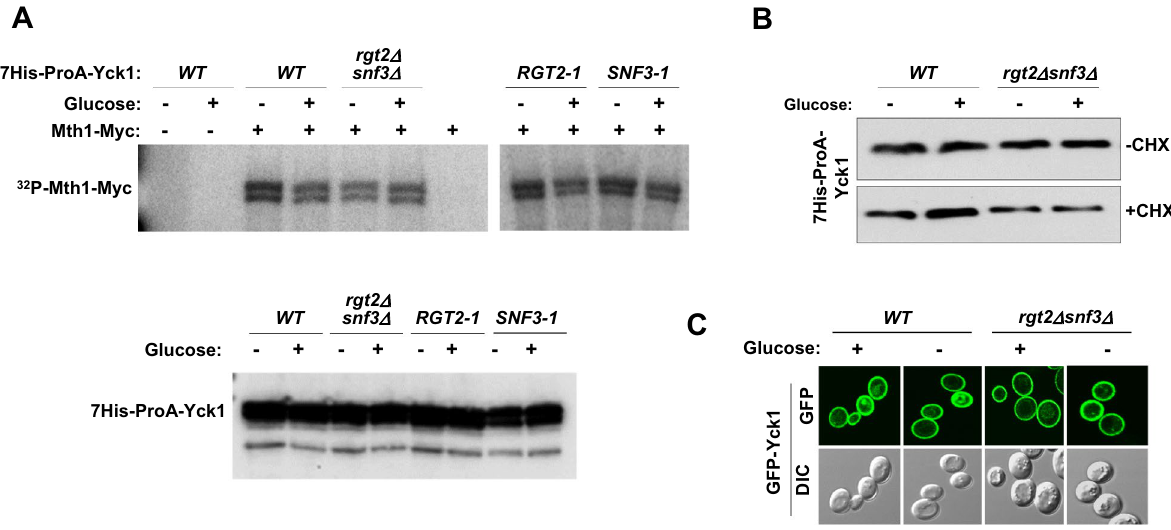
Figure 6. The Ycks are constitutively expressed and active and are not regulated by glucose sensing receptors. ( A ) Mth1-9xmyc (pBM4560) prepared by immunoprecipitation was subjected to in vitro phosphorylation assays using the 7 × His-Protein A-tagged-Yck1(7His-ProA-Yck1, pBM4536) from WT (BY4742), rgt2Δsnf3Δ (YM6370), RGT2-1 (YM6545), and SNF3-1 ((YM6548) yeast strains in the presence of [γ 32 P] ATP, and the radiolabeled proteins were detected by autoradiography after separating them by SDS-PAGE. The indicated yeast strains expressing 7His-ProA-Yck1 were grown in 2% glucose (+) or 2% galactose (−) as described in Fig. 1A (top). 7His-ProA-Yck1 was immunoprecipitated from cell lysates and analyzed by Western blotting using anti- Protein A antibody as a probe (bottom). ( B ) Yeast cells ( WT and rgt2Δsnf3Δ ) expressing 7His-ProA-Yck1 were grown in SC-2% glucose (+) medium to mid-log phase and shifted to 2% galactose (−) medium with or without cycloheximide (CHX, 50 µg/ml) for 1 h. Membrane fractions were immunoblotted with anti-HA antibody. ( C ) WT (BY4742) and rgt2Δsnf3Δ (YM6370) strains expressing GFP-Yck1 were grown in glucose (2%) or galactose (2%) as described above and analyzed by confocal microscopy. Yeast cells were observed under the Zeiss LSM 510 META confocal laser scanning microscope. DIC and GFP fluorescence images are